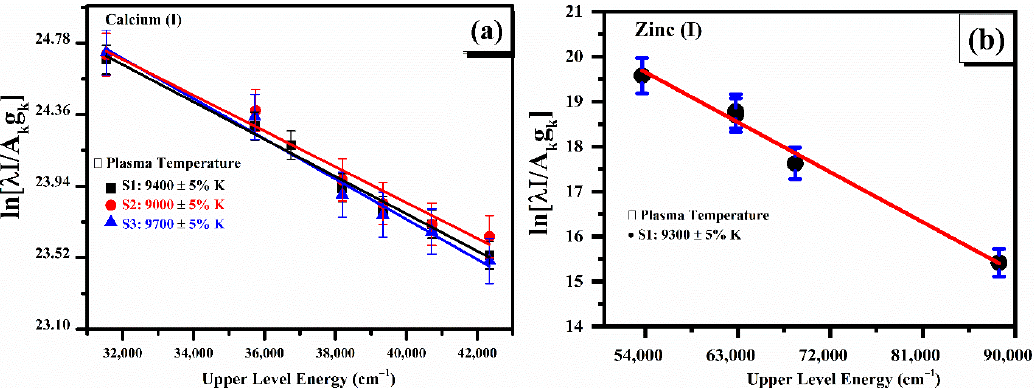
Figure 4. ( a ) Typical Boltzmann plots for the three plant-biochar samples (S1, S2 and S3) using several neutral emission lines of Ca (I); ( b ) shows the Boltzmann plots for sample (S1) using zinc (I) emission lines.